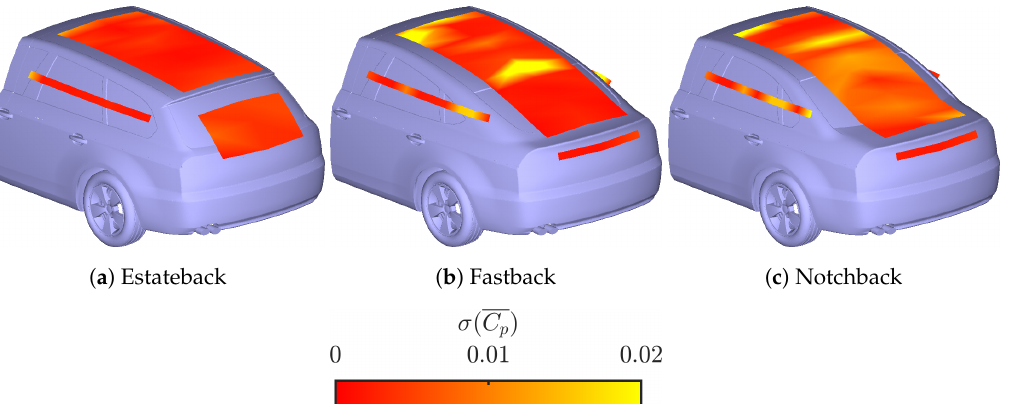
Figure 12. RMS of the surface pressures taken during the Y = − 0.190 m acquisition.